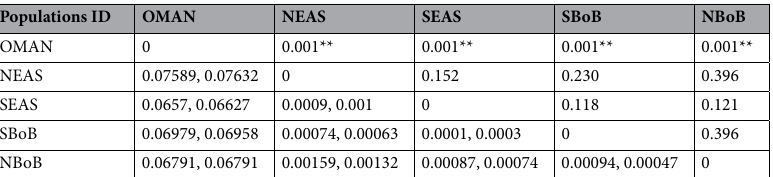
Table 2. Pairwise comparison of genetic divergence (F ST , R ST ) among S. longiceps populations. Below diagonal; genetic divergence among populations as measured by F ST , R ST . Above diagonal; p -value of exact G test for